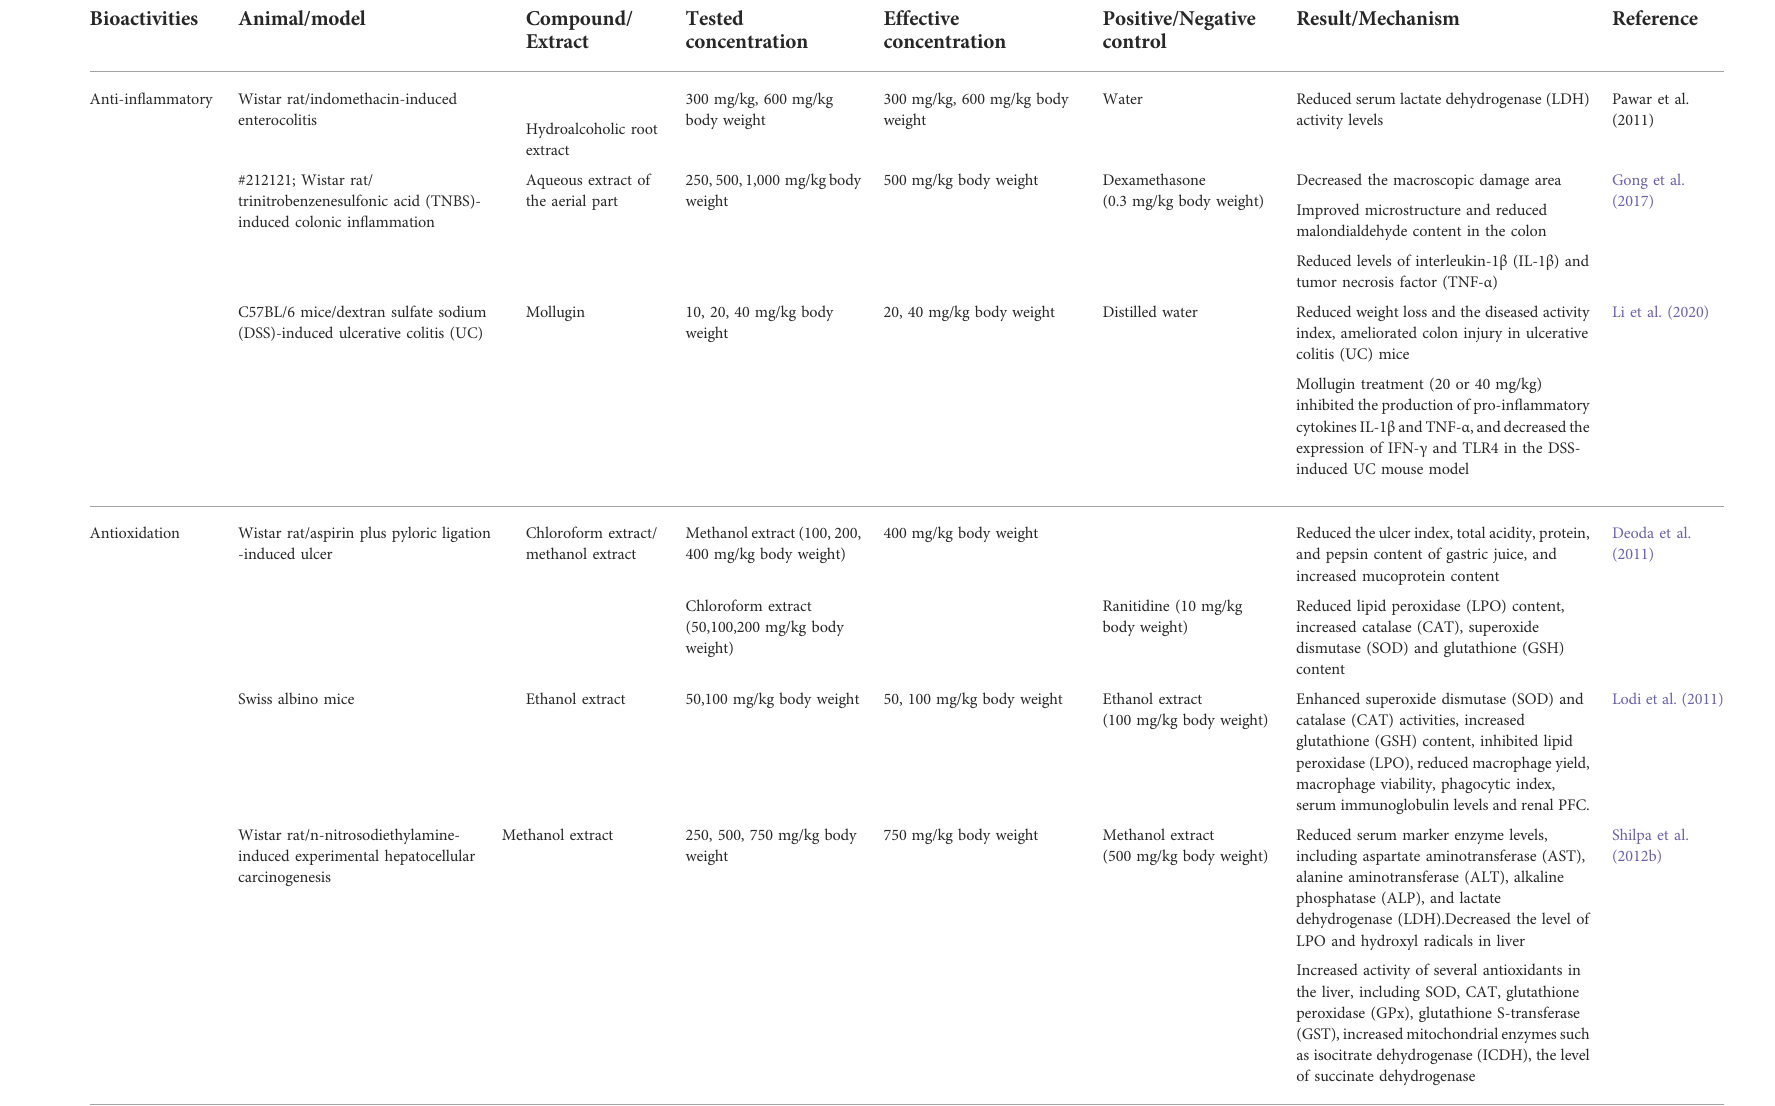
TABLE 3 In vivo study on the pharmacological effects of R. cordifolia